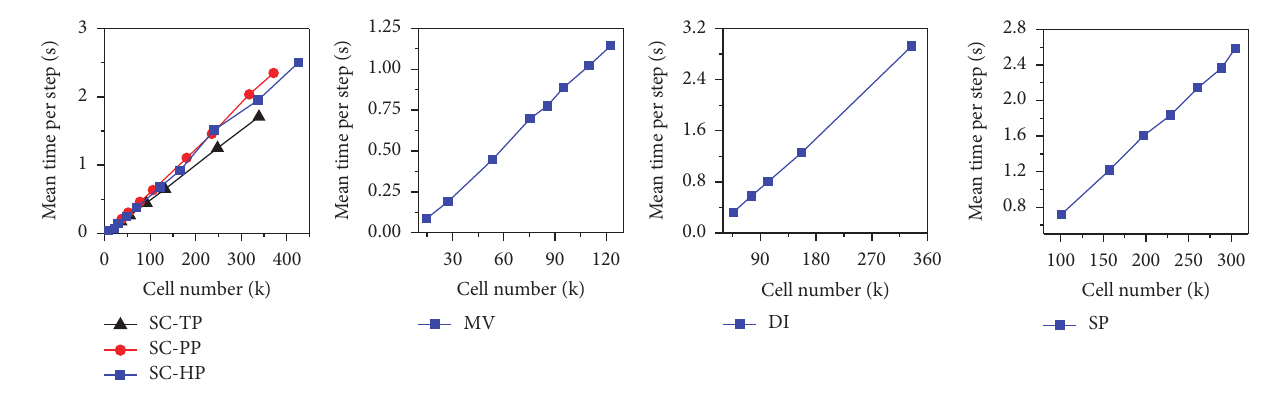
Figure 18: Analysis of the influence of mesh density.